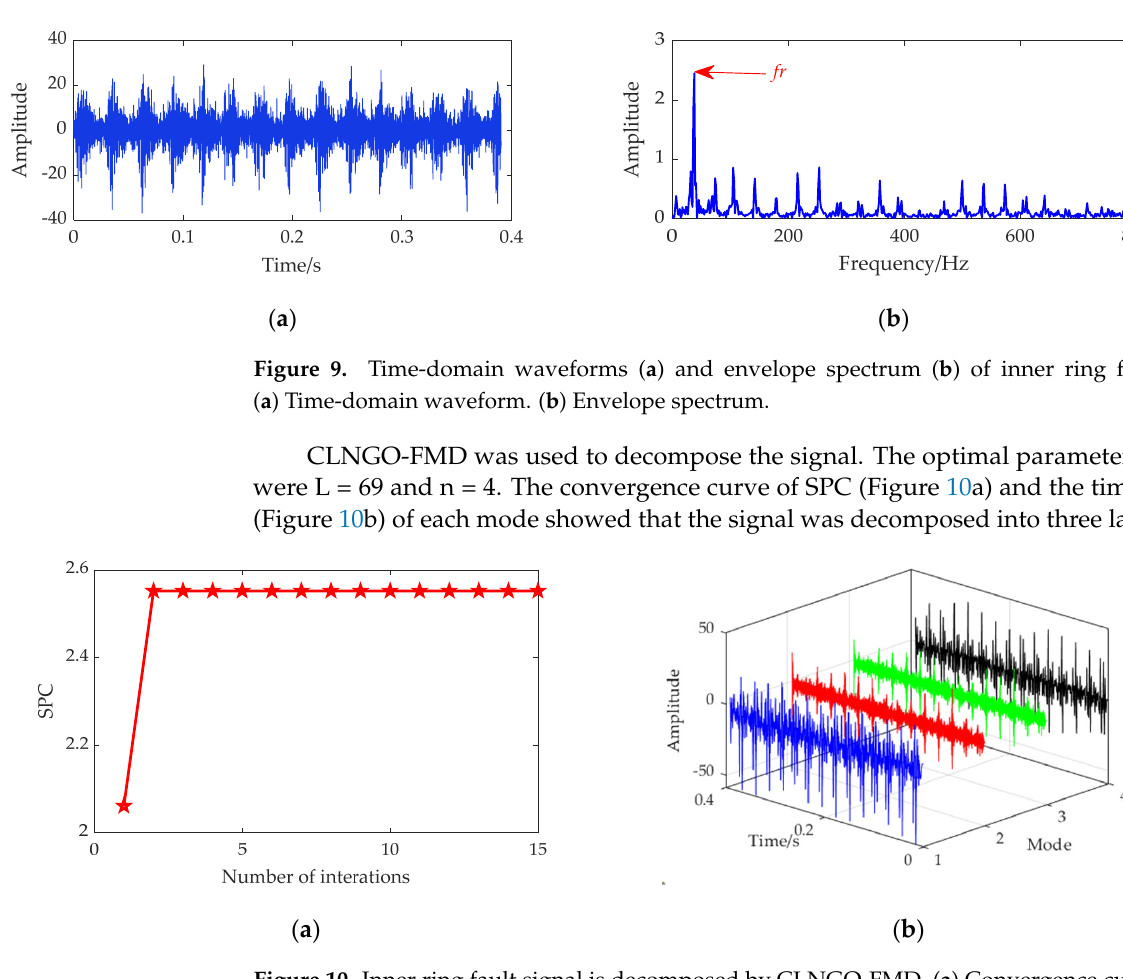
Figure 10. Inner ring fault signal is decomposed by CLNGO-FMD. ( a ) Convergence curve of SPC. ( b ) Time-domain waveform.